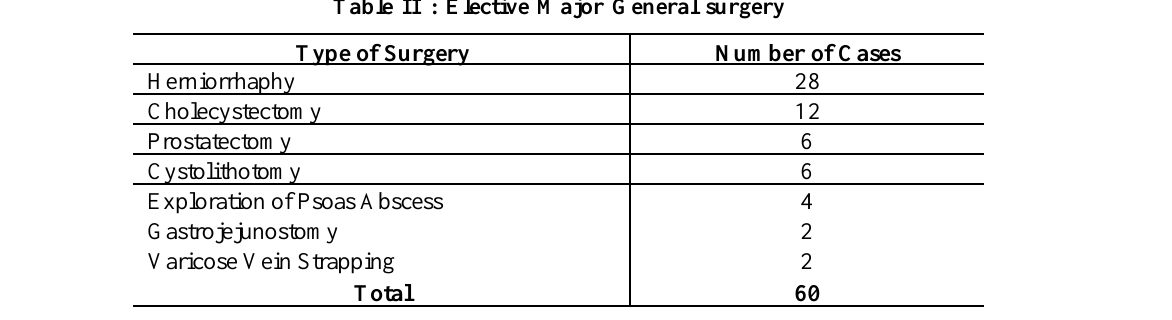
Table II : Elective Major General